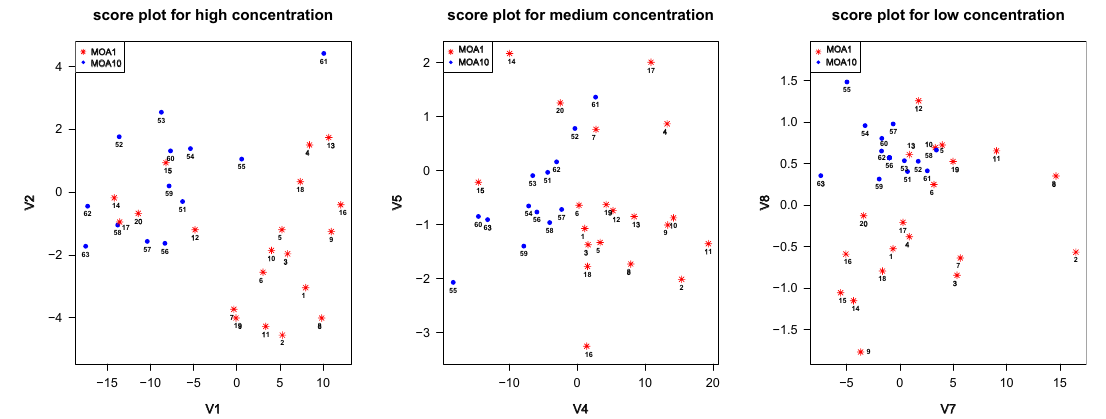
Figure 4. Score plots for the concentration levels. Red stars represent chemicals in MOA group 1 and blue dots those in MOA group 10.